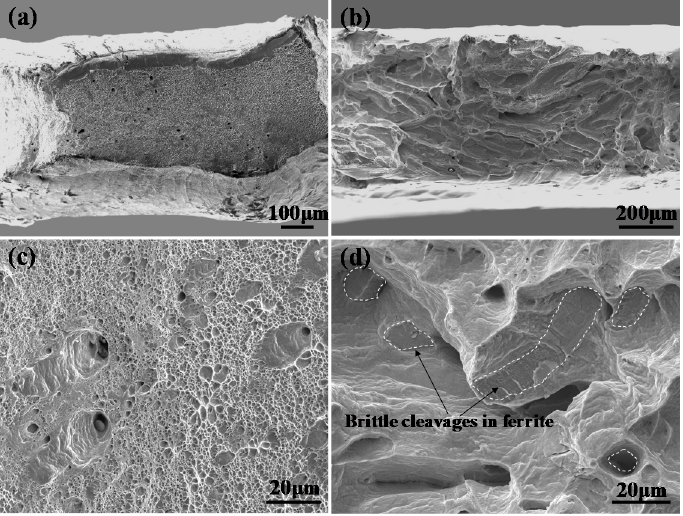
Figure 3. ( a , c ) Macroscopic and microscopic morphologies of the fracture surface of the un-aged CDSS ( b , d ) and of the long-term thermally aged